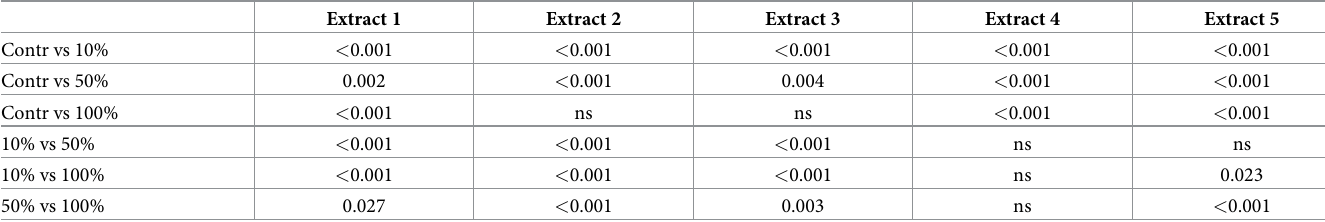
Table 2. Effects of extracts of intervertebral disc tissue on the metabolic activity of human MSCs. P-values after statistical analysis.